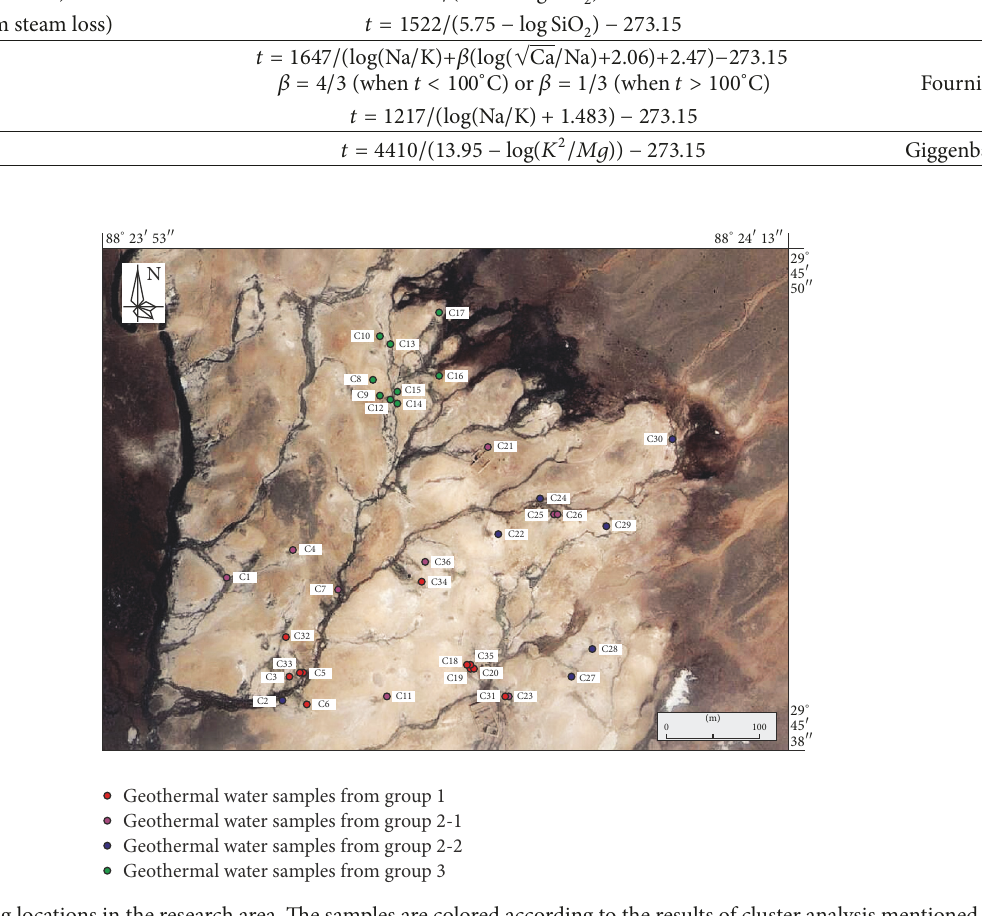
Figure 3: Sampling locations in the research area. The samples are colored according to the results of cluster analysis mentioned in “Cluster